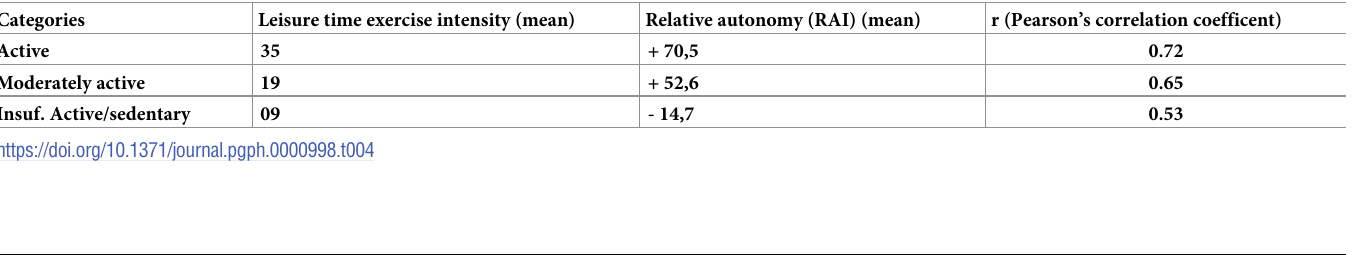
Table 4. Intensity of exercise and relative